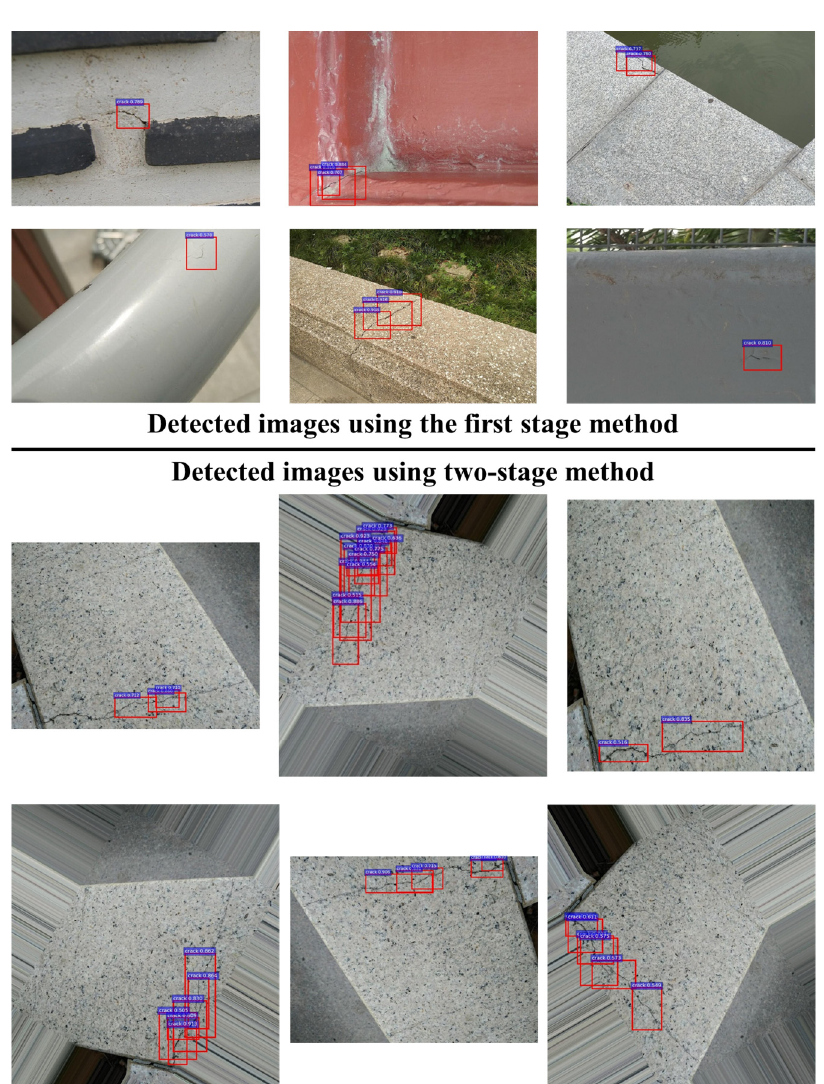
Figure 11. Detected crack images with red boxes. The images above the horizontal line are the examples of crack detection only using the first-stage method. The images below the horizontal line are the examples of crack detection using the two-stage method. By augmenting the image to be detected into a series of augmented images, the trained model has more chances to detect and identify any missing targets when processing an image.